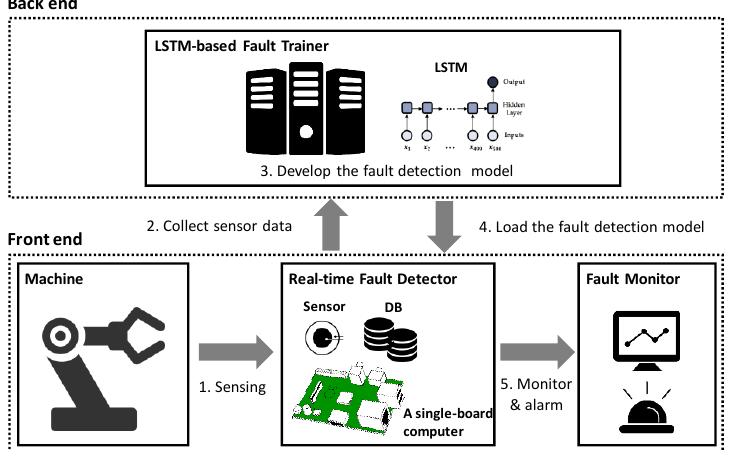
Figure 1. Architecture of the LiReD system.